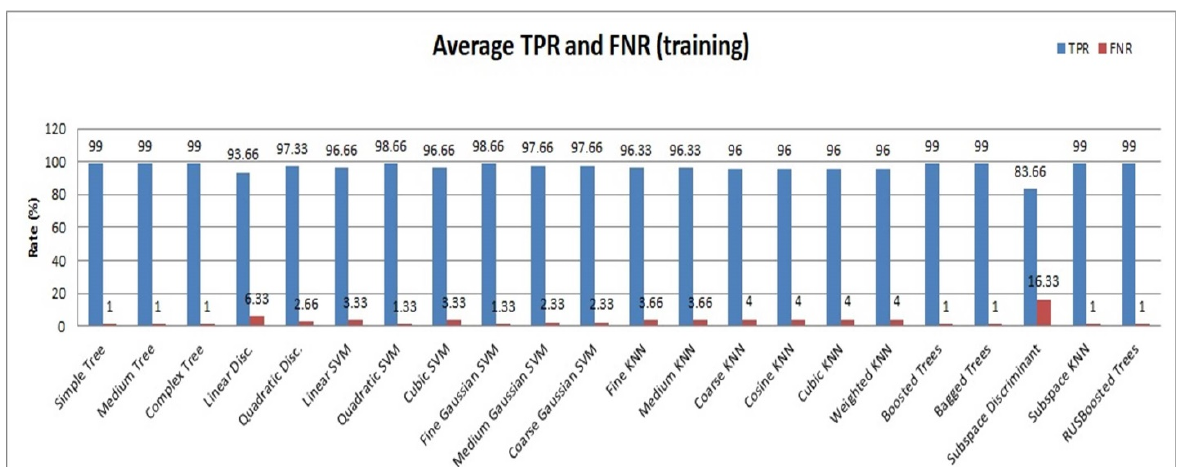
Fig. 4: Average TPR and FNR of machine learning algorithms during training